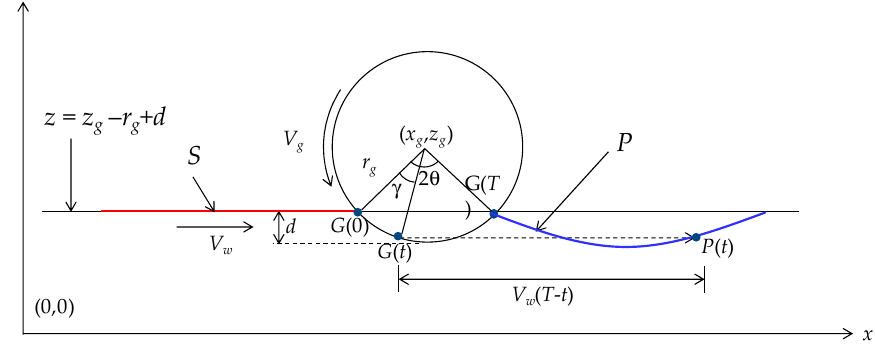
Figure 3. Grinding by a single grain.